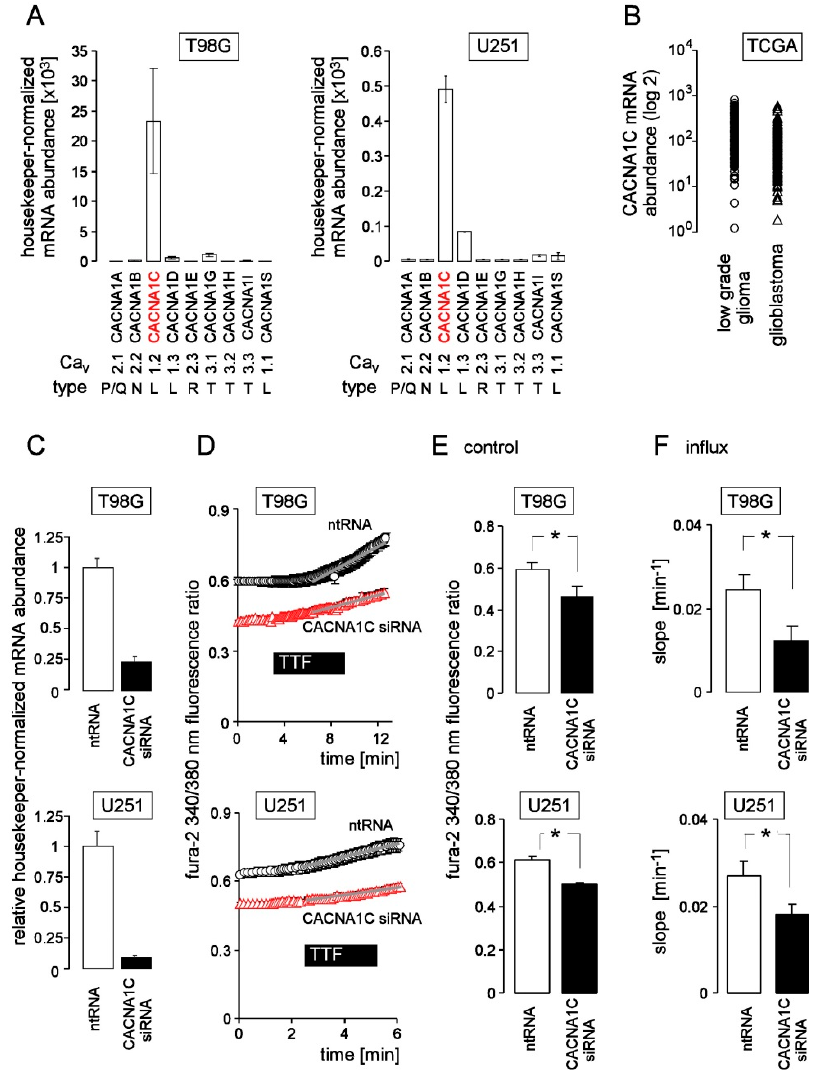
Figure 5. The voltage-gated L-type Ca 2+ channel CACNA1C (Ca v 1.2) contributes to the TTFields- induced Ca 2+ entry. ( A ) Mean (± SE; n = 3) housekeeper-normalized mRNA abundances [× 10 3 ] of P/Q- , N-, L-, R- and T-type Ca v channels CACNA1A, -1B, -1C, -1D, -1E, -1G, -1H, -1I, and -1S (as indicated) in T98G (left) and U251 (right) cells as determined by real-time RT-PCR indicating expression of CACNA1C in both human glioblastoma lines. ( B ) CACNA1C mRNA abundances (log2 RNA seq data) of human low grade glioma (left) and glioblastoma (right) specimens vary considerably between individual tumors. The provisional Glioblastoma-Multiforme and Lower-Grade-Glioma TCGA databases (http://cancergenome.nih.gov/) were queried for CACNA1C mRNA abundance in the tumor specimens via the cBIOportal Web resource [46,47]. ( C ) Mean (± SE; n = 3) relative housekeeper- normalized abundance of CACNA1C mRNA in T98G (top) and U251 (bottom ) cells 48 h after reverse transfection with CACNA1C-siRNA (closed bars) or non-targeting RNA (ntRNA, open bars). ( D ) Mean (± SE; n = 6–19) fura-2 340/380 nm fluorescence ratio of CACNA1C siRNA (red triangles)- or ntRNA-transfected (open circles) T98G (top) and U251 cells (bottom), before, during and after application of TTFields (200 kHz, 2.5 V/cm, 3–5min). ( E,F ) Mean (± SE; n = 6–19) control ratio ( E ) and TTFields-induced increase in ( F ) fluorescence ratio of CACNA1C siRNA (red bars)- or ntRNA- transfected (open bars) T98G (top) and U251 cells (bottom). * indicates p ≤ 0.05, Welch-corrected t - test). To study the interaction of TTFields with cell biology, we developed a cell culture TTFields applicator that applied 200 kHz sine wave electrical fields to a multi-well plate (Figure 6A). The field (1 V/cm peak-to-peak amplitude) was injected perpendicular to the cell layer in a capacitive manner